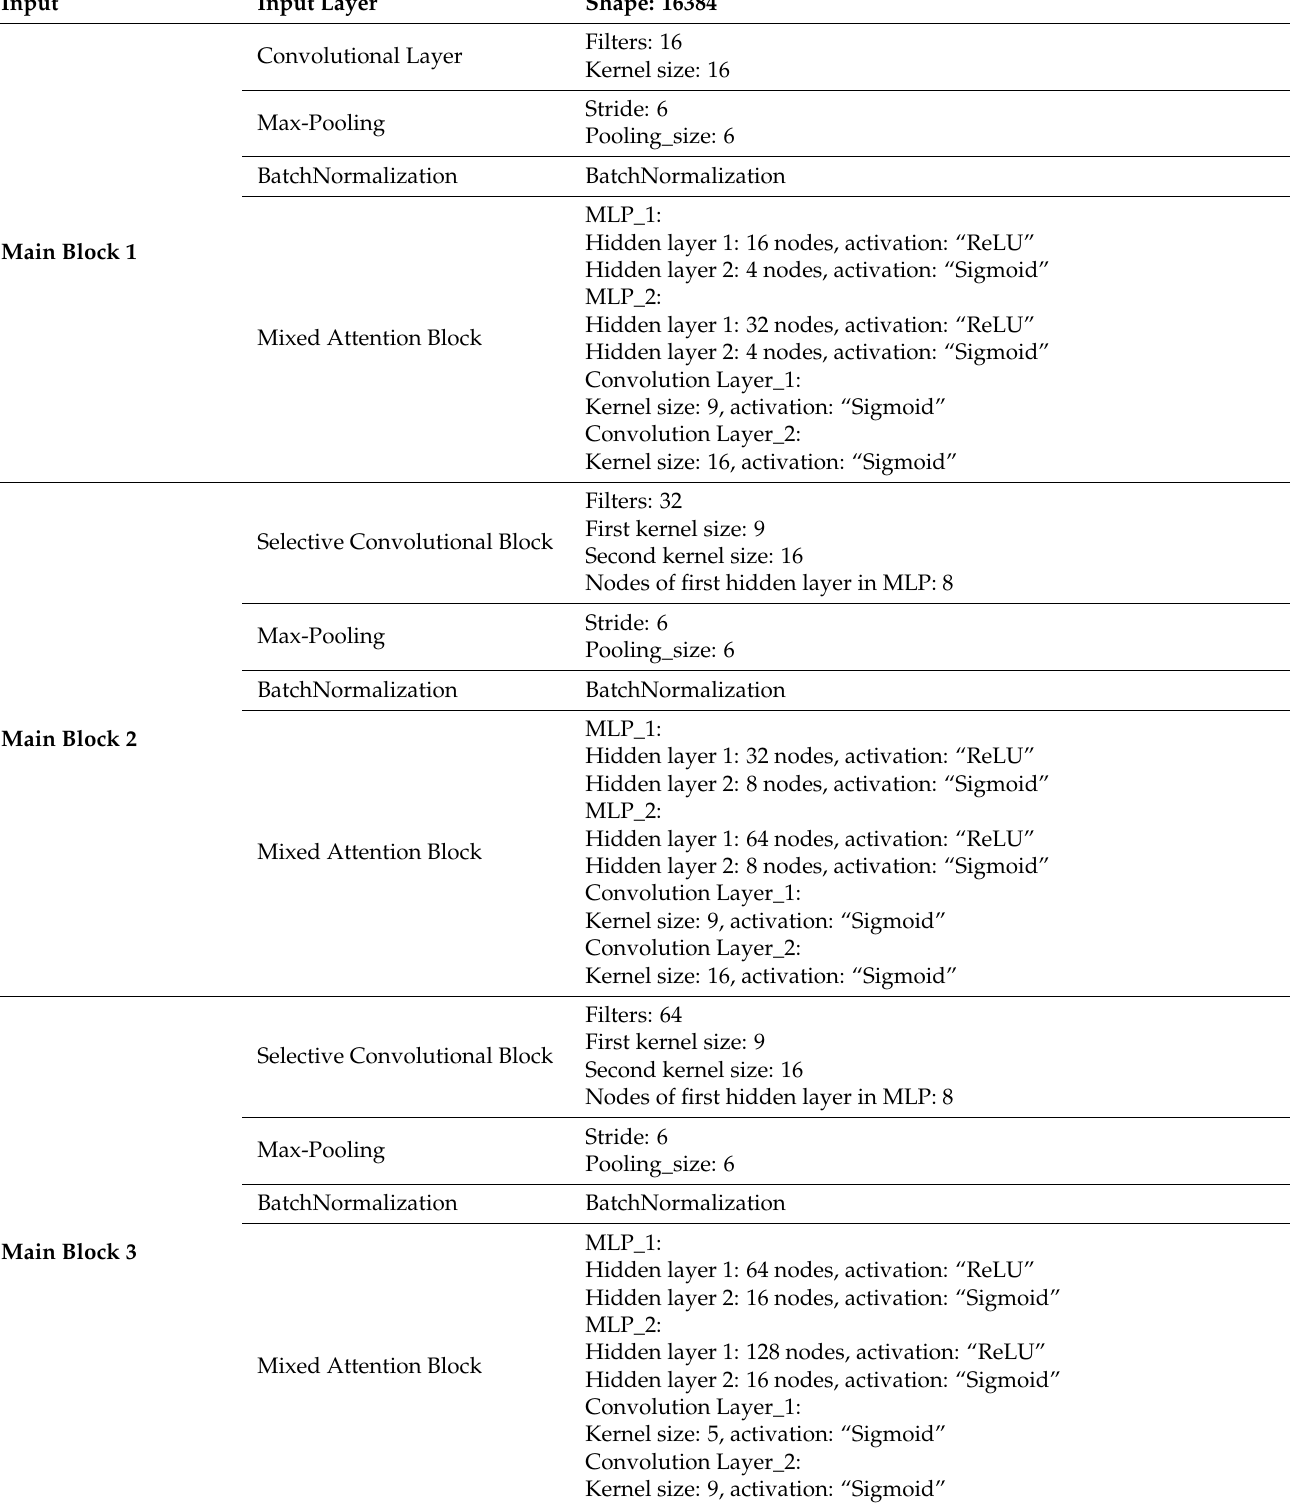
Table 2. The parameters of